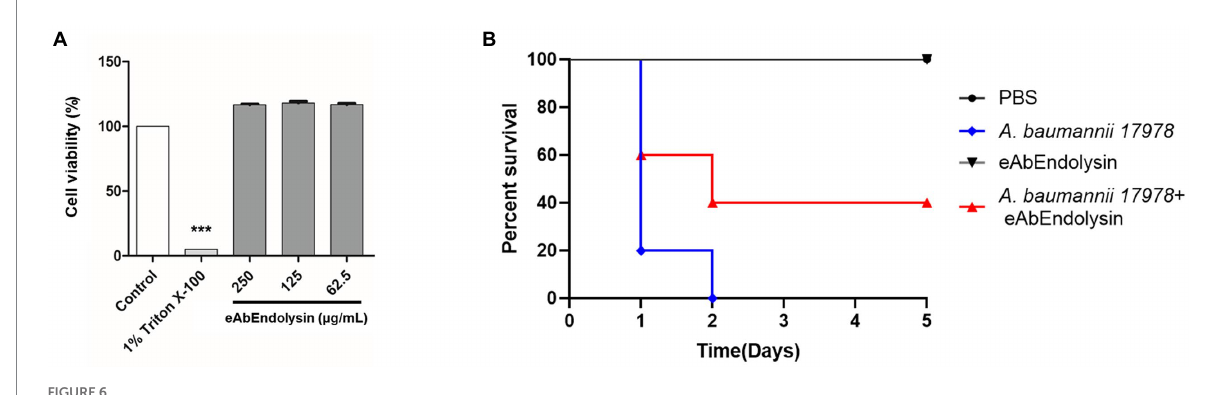
FIGURE 6 Cytotoxicity and antibacterial efficacy of eAbEndolysin in the mouse systemic infection model. (A) Cytotoxicity assay of eAbEndolysin in human alveolar cell line A549. The cells were suspended in 100 μ l (5 × 10 3 cells/well), seeded in 96-well plate, and incubated with eAbEndolysin (final concentration: 250–62.5 μ g/ml) for 24 h. PBS and 1% Triton X-100 were used as negative and positive controls, respectively. (B) Survival rates for mice infected with A. baumannii (2 × 10 8 CFU). The mice were intraperitoneally injected with PBS (control group), A. baumannii ATCC 17978 (infection group), 125 μ g/ml of eAbEndolysin (safety test group), or A. baumannii +125 μ g/ml of eAbEndolysin (treatment group). The mice in each group were treated with eAbEndolysin 0.5 h after infection and monitored for 5 days for post-infection survival. Statistical significance was determined using a one-way ANOVA with multiple comparison across treatment groups. (*** p <